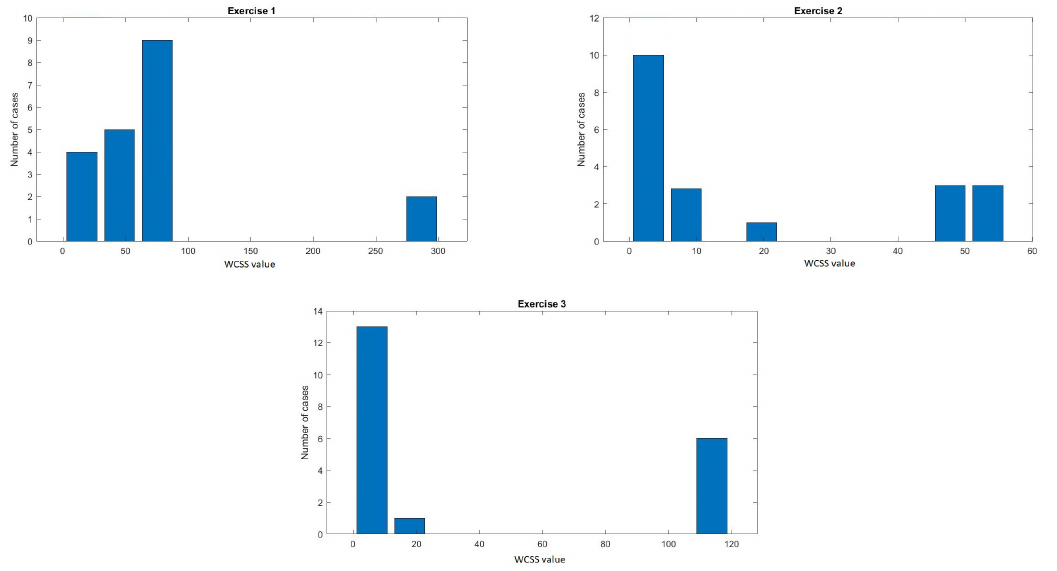
Figure 7. Histogram of Within-Cluster-Sum-of-Squares (WCSS)